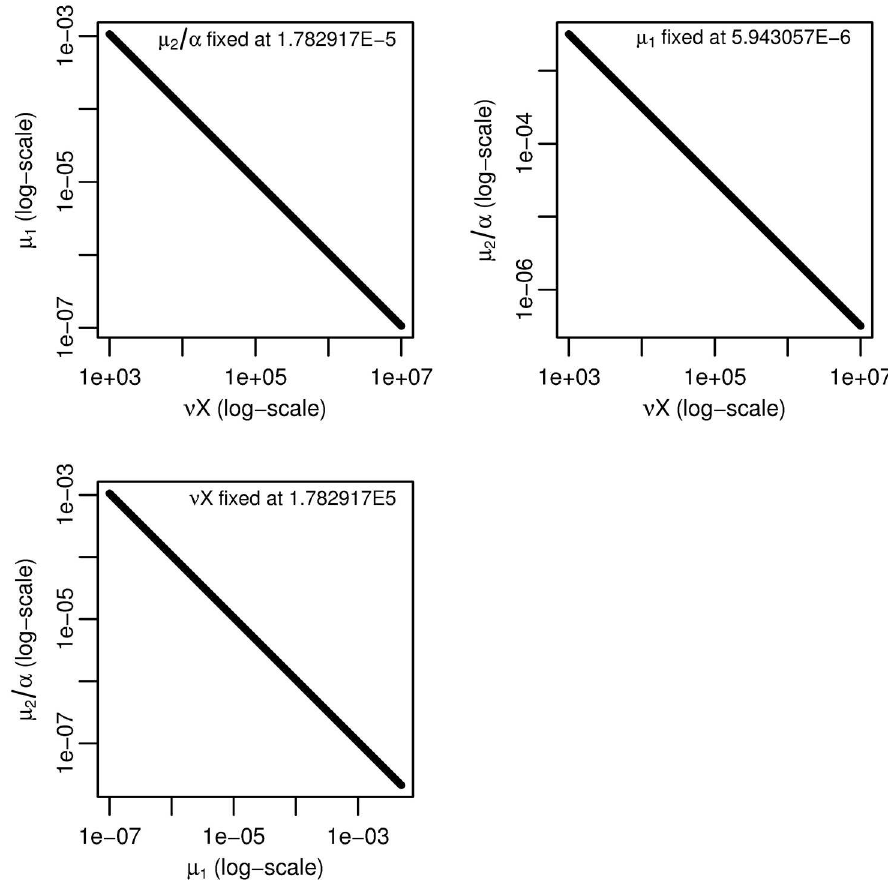
Fig 9. Four-stage model parameter dependencies. Fitted values of one of ν X , μ 1 , or μ 2 / α as another is fixed and the third is varied for the four-stage model. The linear relationshipson a log–logscale indicatethat ν X μ 1 μ 2 / α is an identifiable